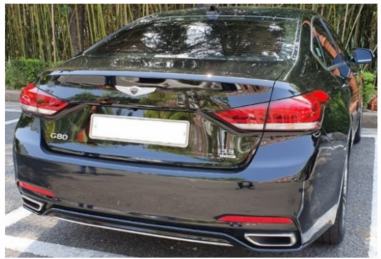
Figure 4. Test vehicle-Hyundai Genesis